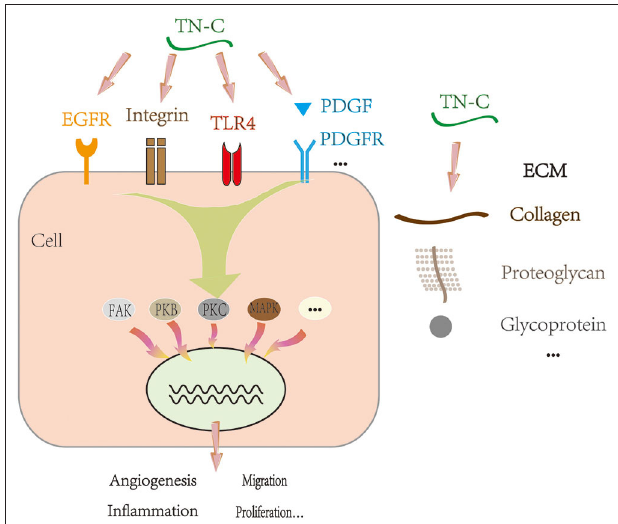
FIGURE 2 | Proposed mechanism of TN-C under physiological and pathological conditions. EGFR, epidermal growth factor receptor; TLR4, Toll-like receptor 4; PDGF, platelet-derived growth factor; PDGFR, platelet-derived growth factor receptor; ECM, extracellular matrix; FAK, focal adhesion kinase; PKB, protein kinase B; PKC, protein kinase C; MAPK, mitogen-activated protein